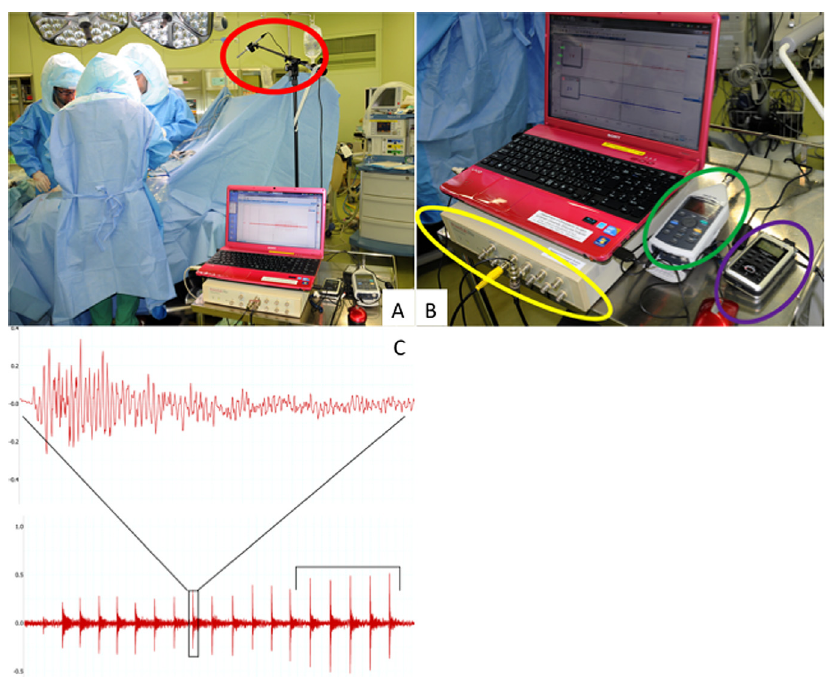
Figure 2. Intraoperative sound data collection. The sound made with the impactor during stem implantation was recorded (A). A PowerLab data logger and performed sampling at 40 k/s was used (B). A sound analysis specialist analysed the data in a blind fashion